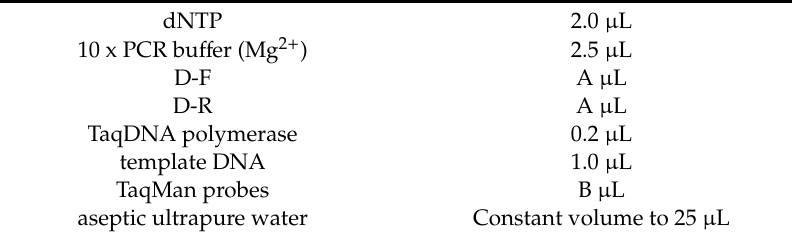
Table 2. Real-time fluorescent PCR reaction